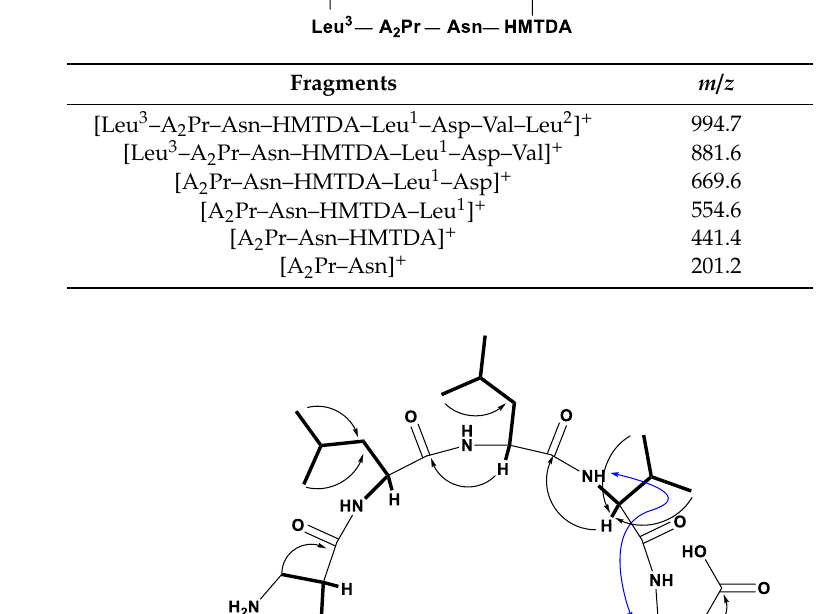
Table 2. (+) FABMS parent and fragment ions of compound 1 .